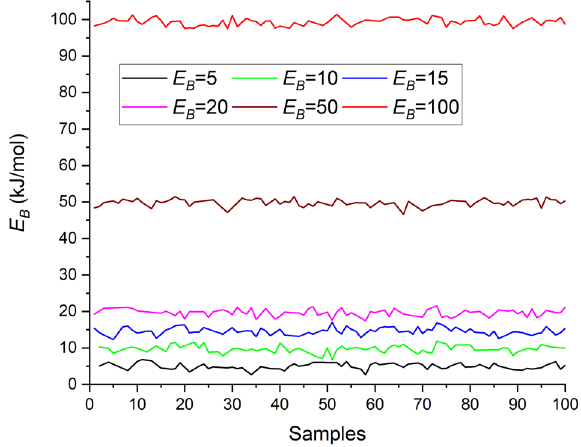
Fig. 4 Estimated E B values at different steps of the dissolution process. Values indicated in the legend are the exact values.